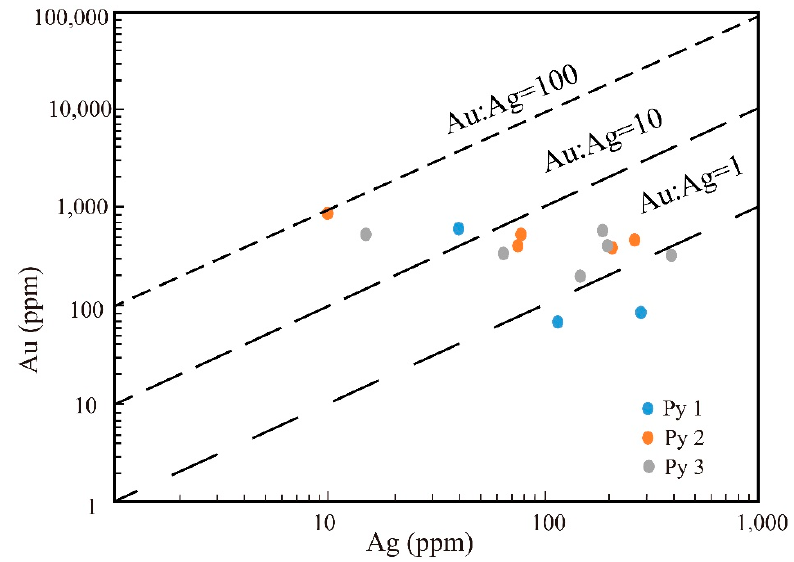
Figure 7. Binary element plots of Au versus Ag plots (in ppm) of pyrite grains in Fang’an gold